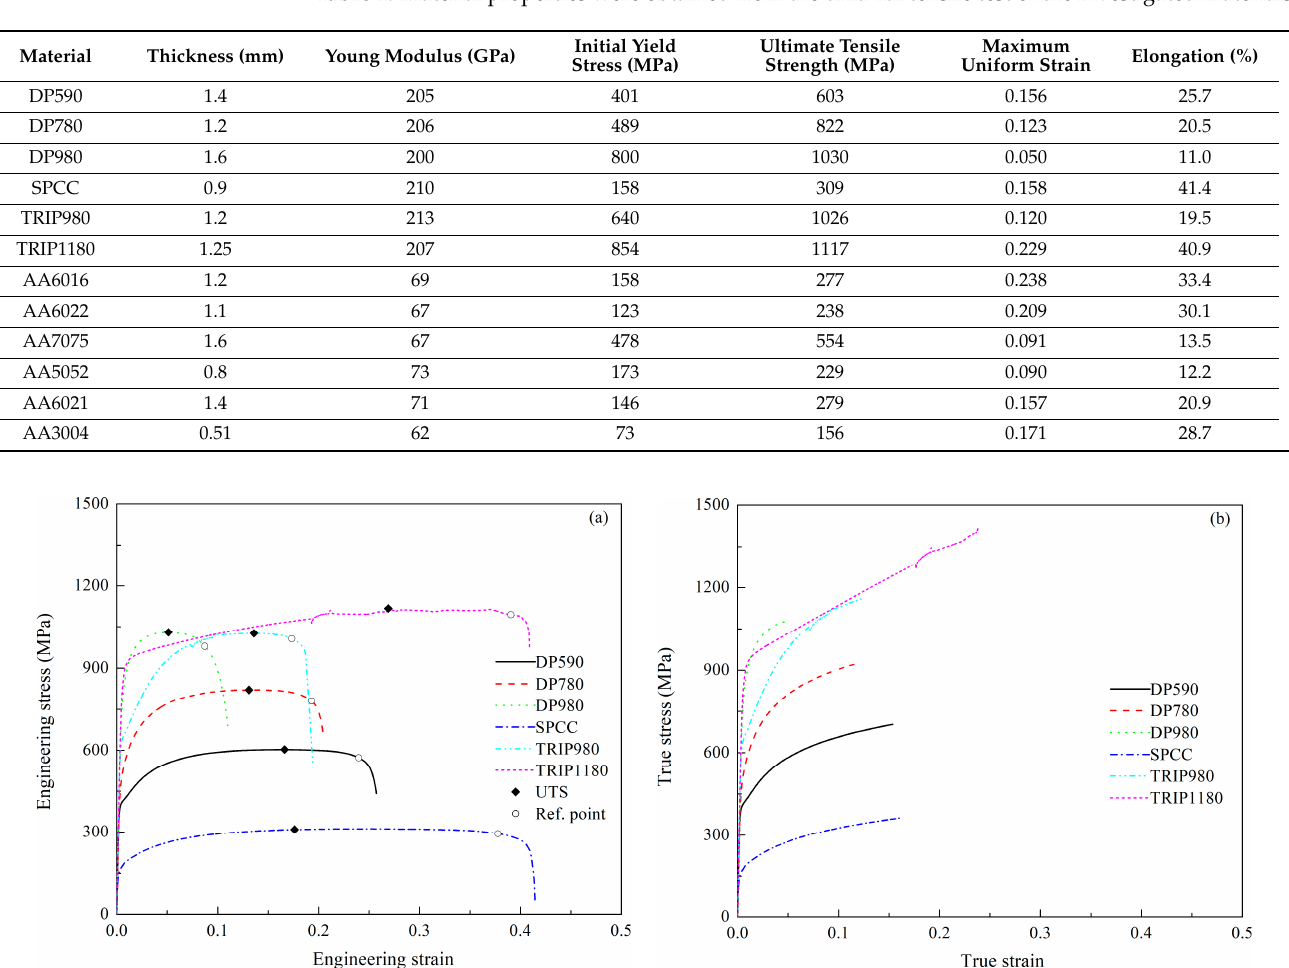
Figure 4. Stress-strain data obtained from uniaxial tensile tests for six aluminum alloy sheets. ( a ) Engineering stress-strain curves. ( b ) True stress-strain curves. It is seen that the variation of the Young modulus of steel sheets determined from the tests is negligible, which is close to a value of 200 GPa, approximately. The measured Young modulus of aluminum alloy sheets, which is approximated to 70 GPa, yielded sim- ilar results. However, the plastic properties of these materials vary greatly from one an- other. For example, initial yield stresses of steel sheets range from 150 MPa (SPCC) to 1000 MPa (DP980 and TRIP980). The shortest elongation of 10% was observed in the case of the DP980 sheet, whereas, the longest elongation is the more than 40% observed in the case of the TRIP1180. Furthermore, the ultimate tensile strengths (UTS) of the tested materials are marked in Figure 3 and Figure 4 to indicate the ranges of uniform deformations observed during the UT tests. It is well-known that necking begins beyond the points, resulting in inhomo- geneous deformations. Hence, the deformation is concentrated on a narrow regime, sub- sequently leading to the strain localization. Once the strain localization is formed, the fail- ure occurs quickly. In these figures, reference points are depicted to indicate the position of strain localization observed during the tests for each material. These reference points were determined based on the authors’ expertise since there is no standard for detecting the strain localization on the engineering stress - strain data. It is recommended to extract